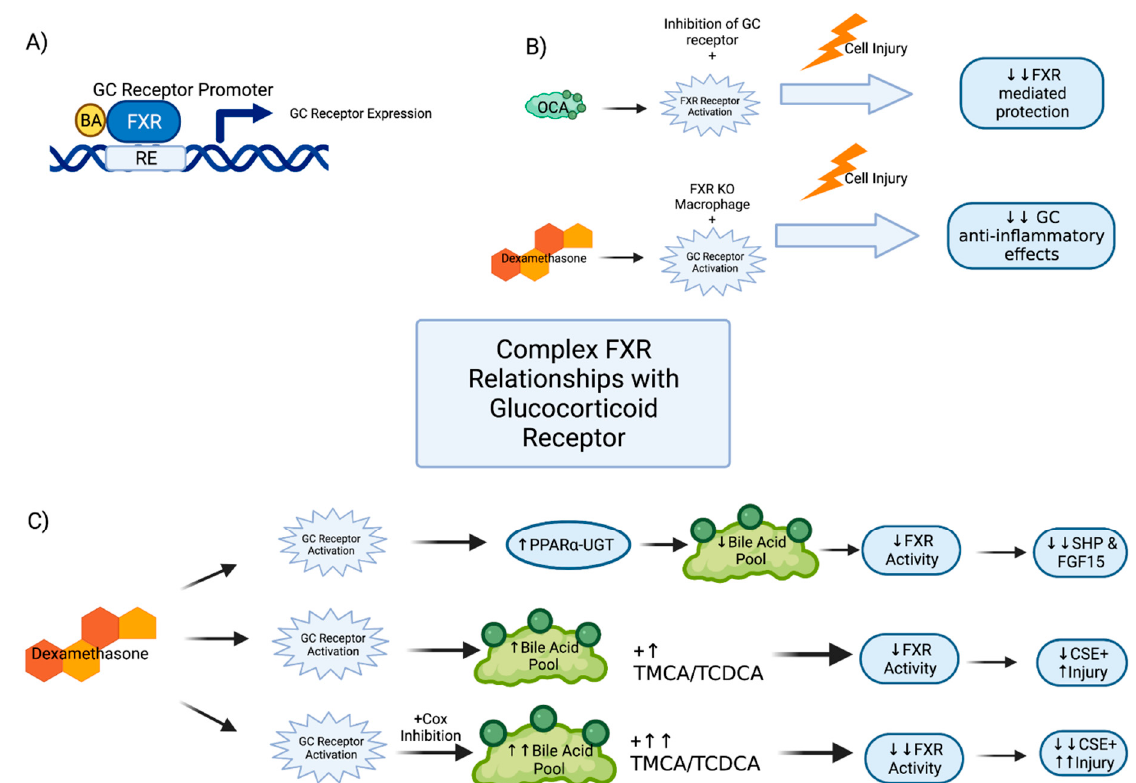
Figure 2. FXR relationship to glucocorticoid receptor function. There are complicated interactions between FXR and GC receptor in both their respective and synergistic responses to cellular insult. ( A ) Transcriptional response elements within the promoter sequence for glucocorticoid receptor RE—response element. ( B ) Synergistic anti-inflammatory relationship between FXR and GC receptor function such that diminishing activity of one affects functional response to injury of the other. OCA—obeticholic acid ( C ) GC receptor activation decreases functional effects of FXR; however, different mechanisms for this effect have been proposed. Additional relationship between FXR, GC receptor and COX activity have also been observed (CSE = cystathione- γ -lyase; SHP—small heterodimer protein, FGF-fibroblast growth factor) (Created with BioRender.com accessed on 10 October 2021).